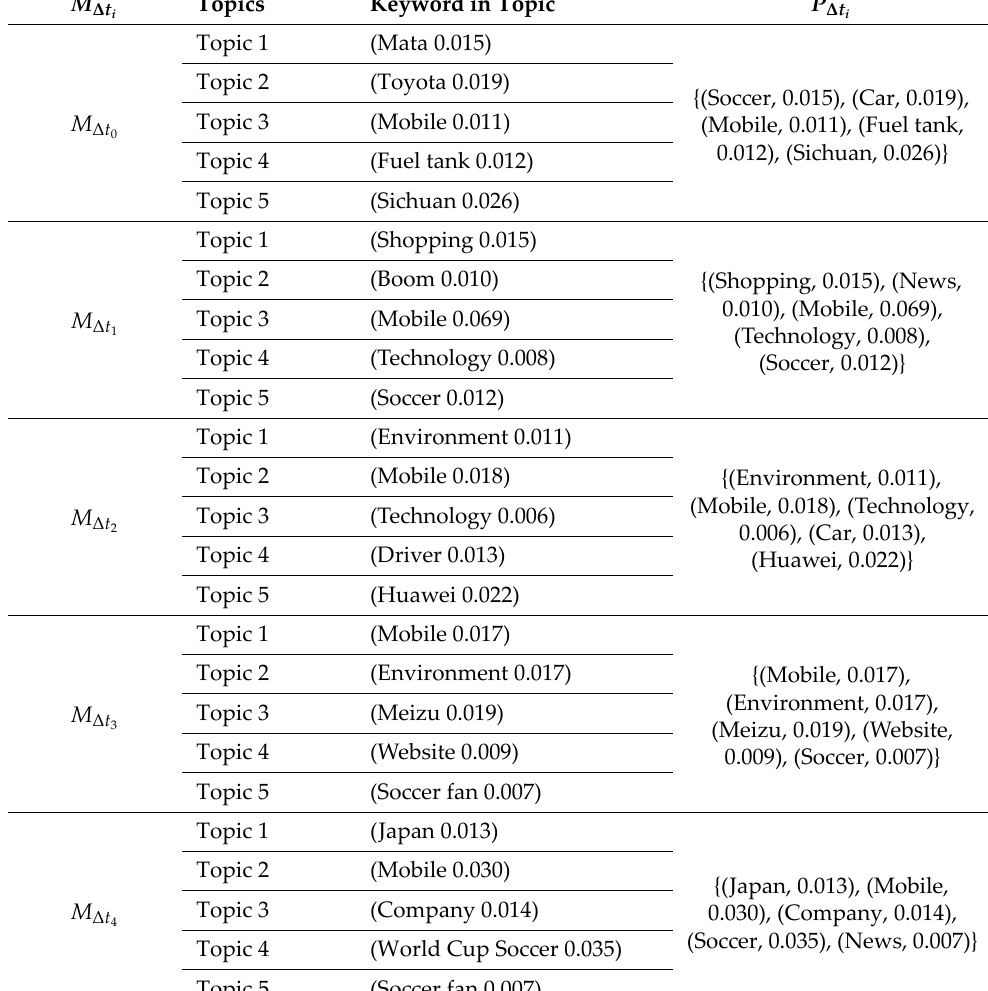
Table 7. Examples of profiles building